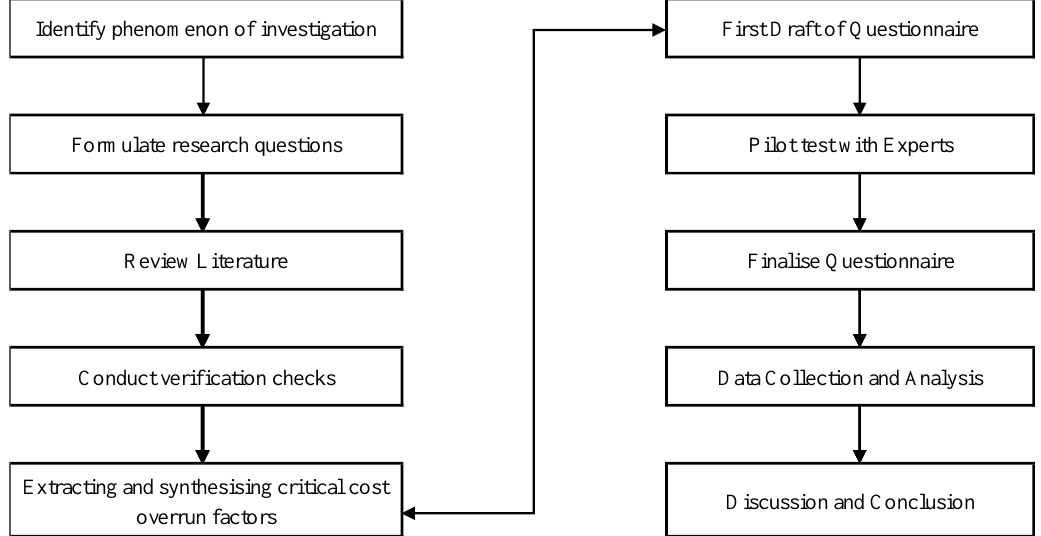
Figure 2. Flowchart of research activities